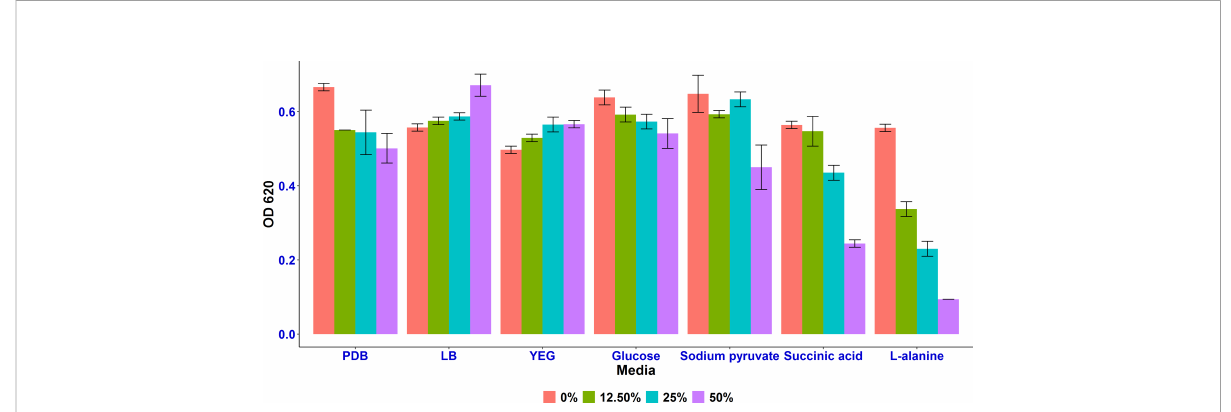
FIGURE 2 Cell density (OD 620 ) of A. tumefaciens SZMC 14557 in the presence of 12.5, 25, and 50% concentration of CCF obtained from the culture supernatant of P. resinovorans SZMC 25872 grown in 7 media. 0% concentration of CCF is positive control (PDB without